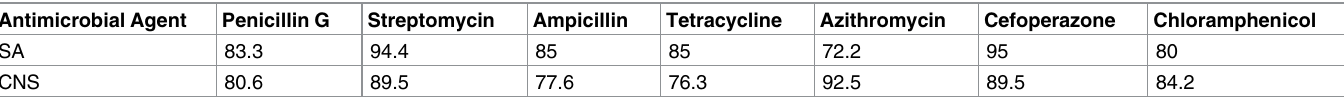
Table 2. Frequencies of antimicrobial resistance identified by disc diffusion of S . aureus and coagulase negative Staphylococci isolated from dry cows in India. Antimicrobial